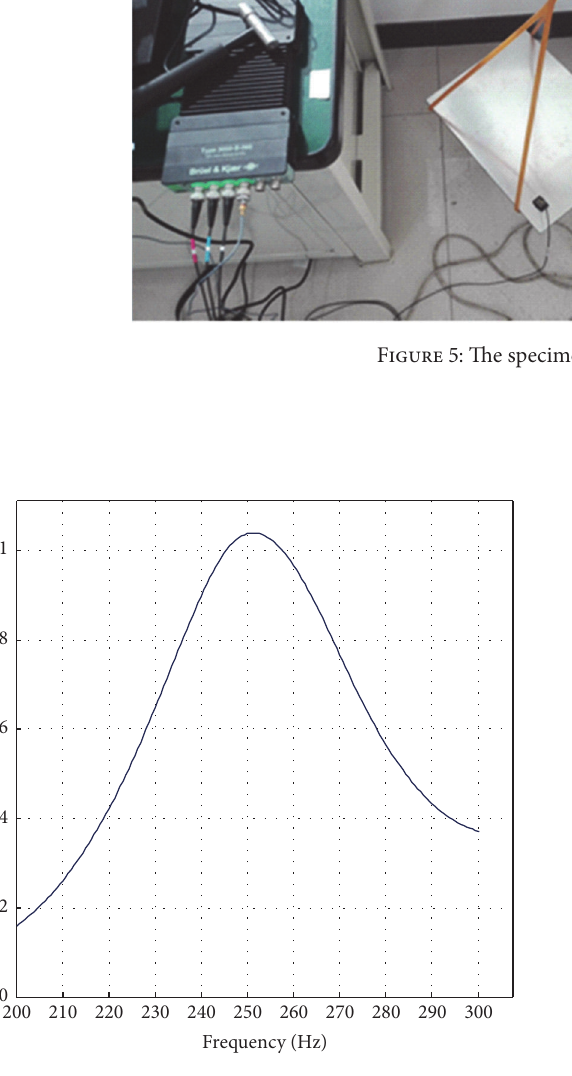
Figure 6: The frequency-domain response.